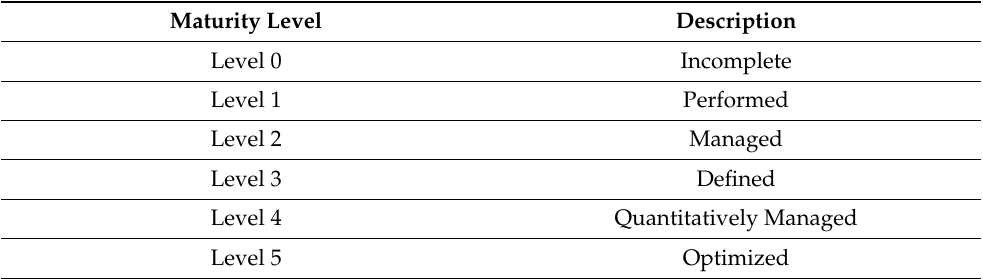
Table 1. Maturity levels.